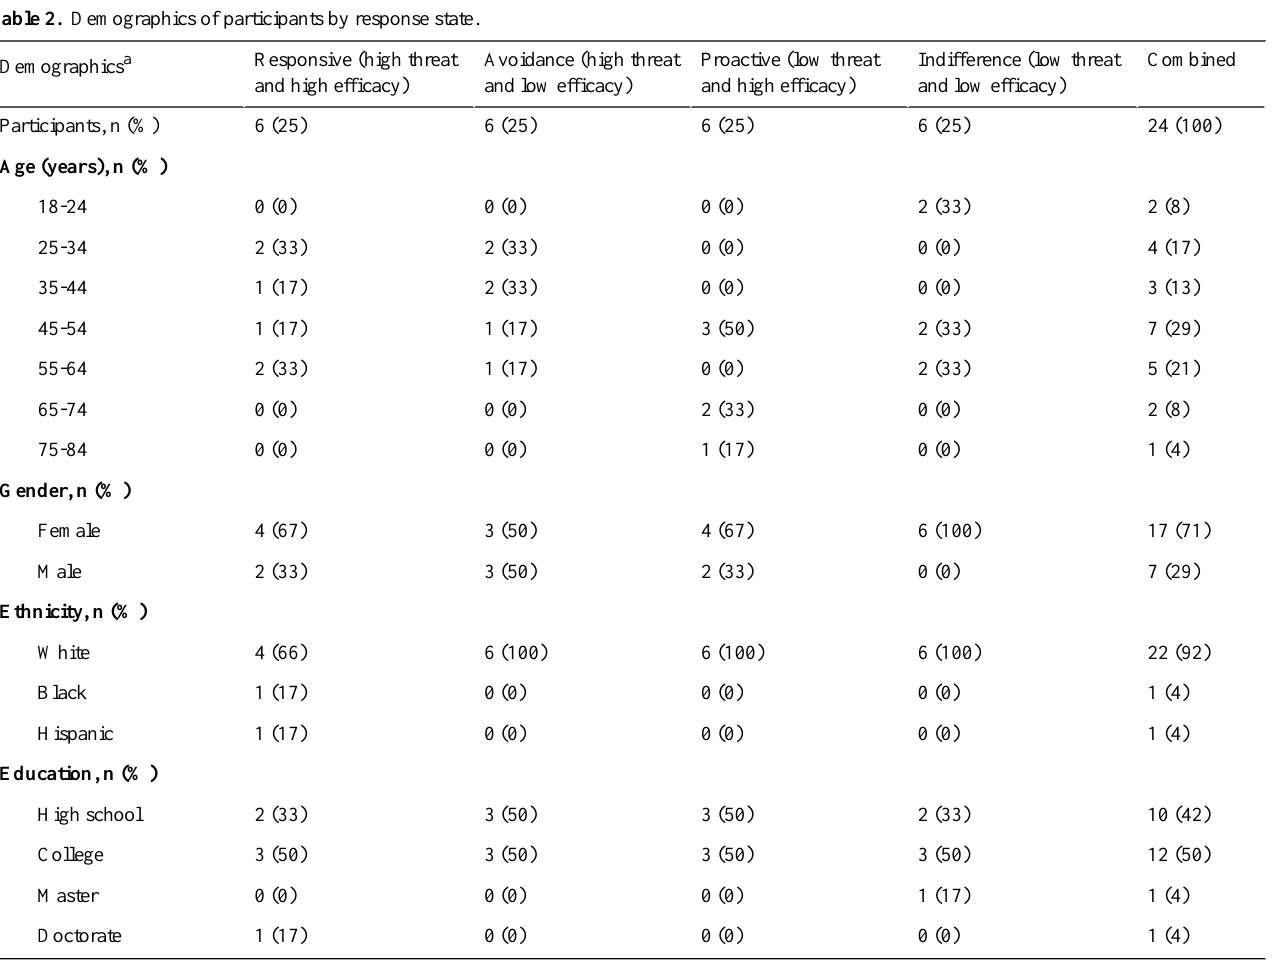
Table 2. Demographics of participants by response